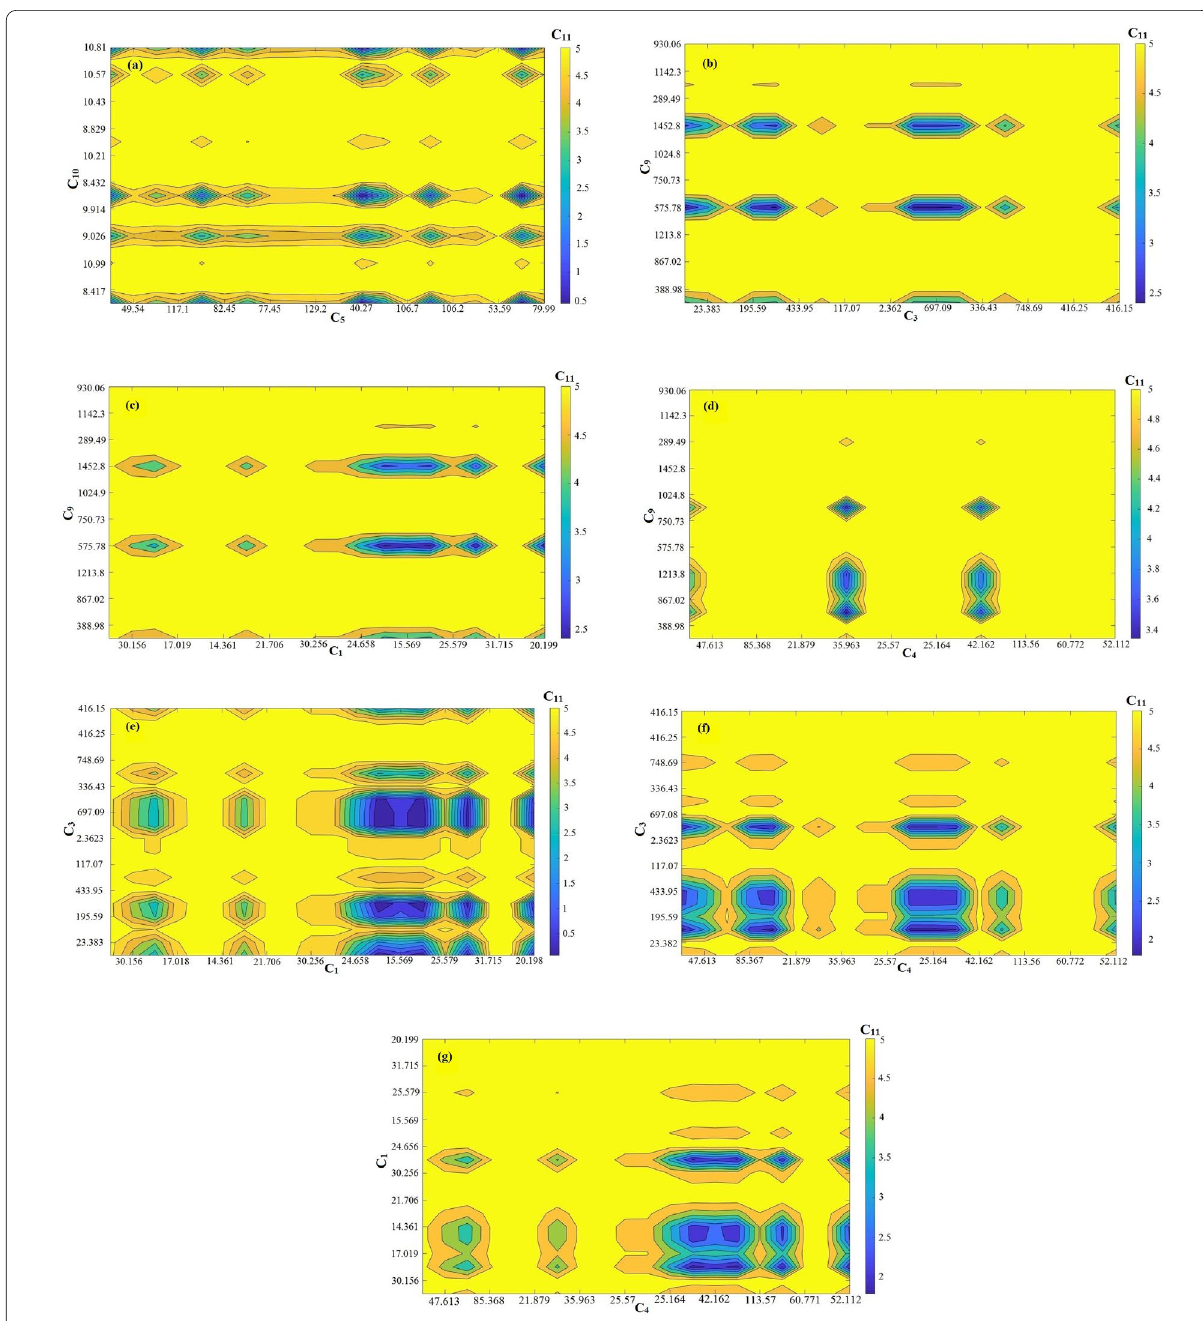
Fig. 20 Binary changes for some of selecting parameters: a C 10 – C 5 , b C 9 – C 3 , c C 9 – C 1 , d C 9 – C 4 , e C 3 – C 1 , f C 3 – C 4 , and g C 1 – C 4